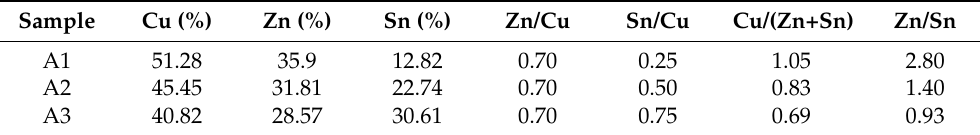
Table 1. The elemental contents of electrodeposited CuSnZn